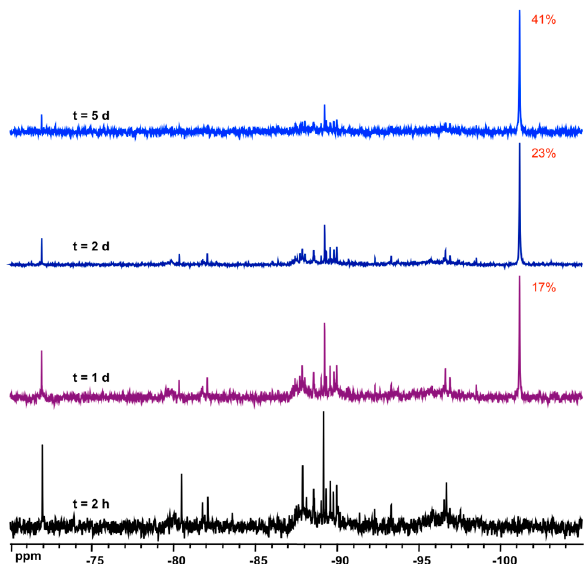
Figure 4. Evolution of 29 Si NMR spectra of the synthesis medium in the system 1 α -CD:6 TEOS:6 KOH:300 D 2 O with time, which shows the growth of the signal of D6R@ α -CD at ca. 101 ppm.